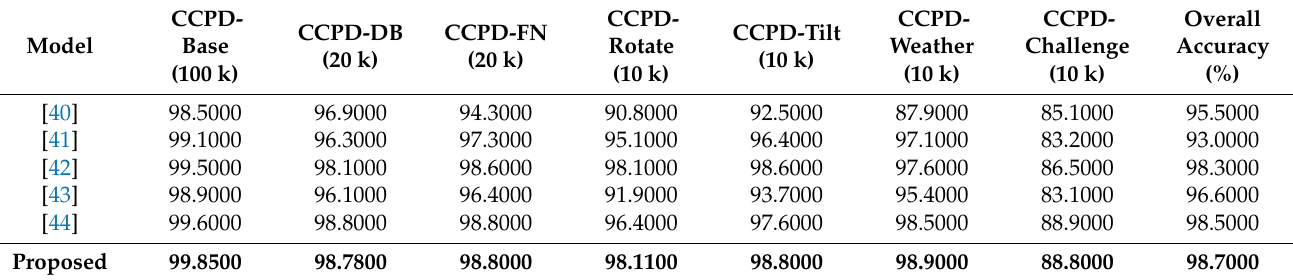
Table 5. Comparison of the CCPD